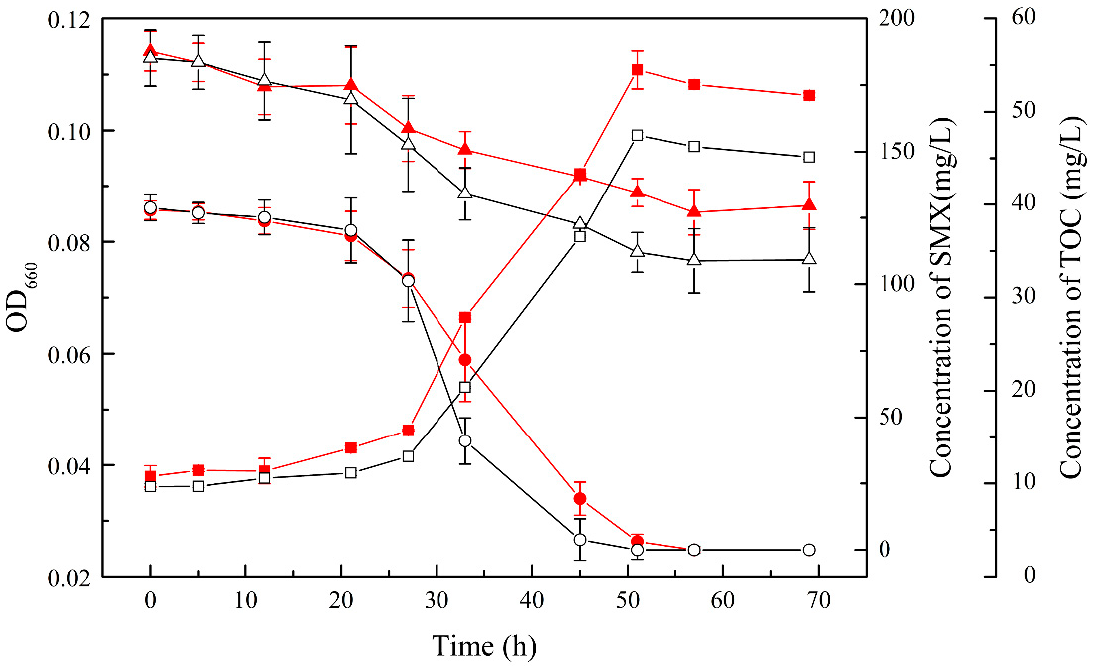
Figure 2. Removal of SMX during the growth of the strain YL1 (red) and the consortium (black). The circle shows the concentration of SMX; the triangle represents the concentration of TOC; square represents OD 660 .